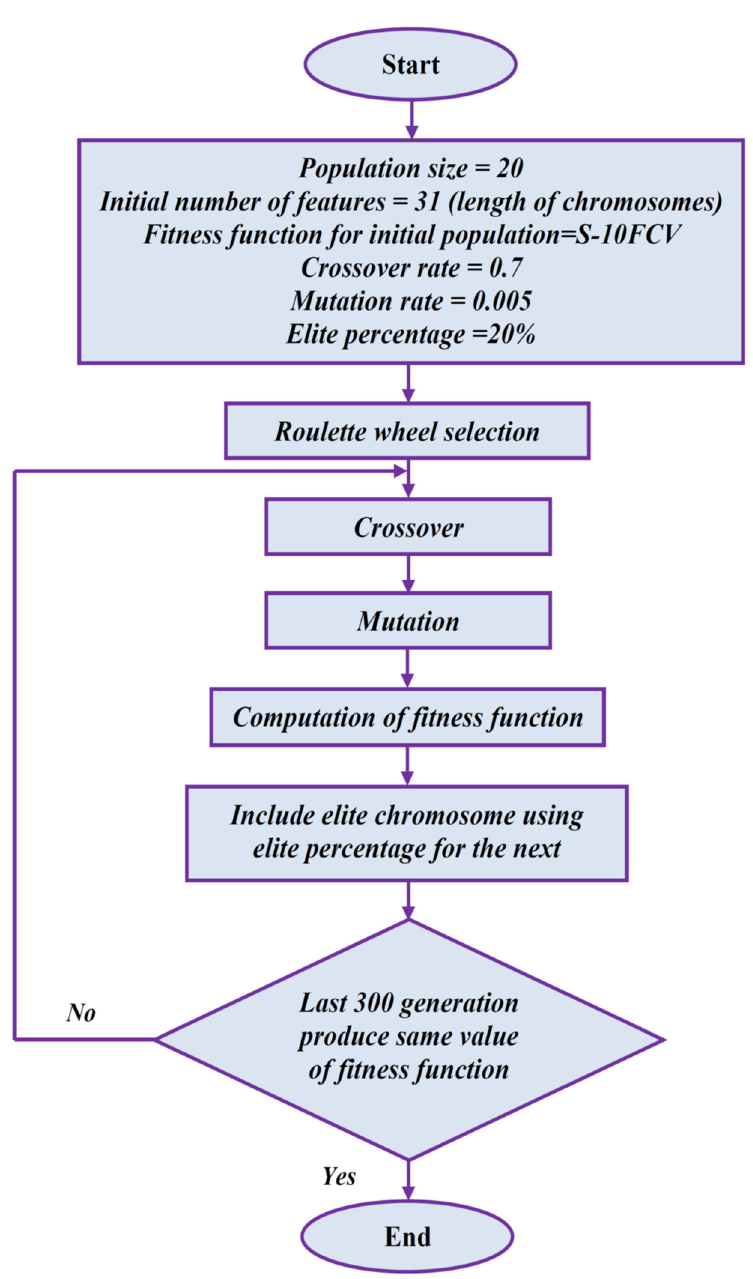
Figure 2. Flow chart of feature selection using proposed algorithm.